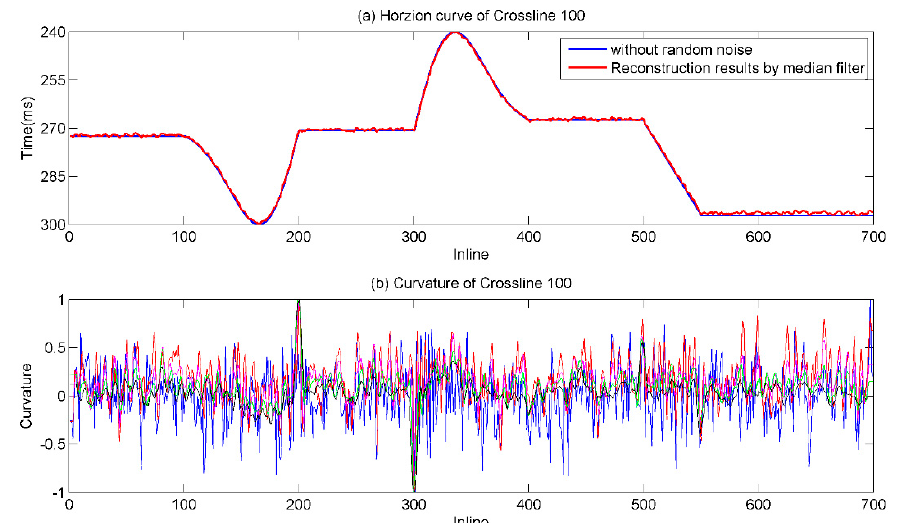
Figure 9. Horizon curve and curvature attributes: ( a ) Reconstruction results of horizon curve by median filter and ( b ) curvature attributes of different time windows after denoising based on median filter.